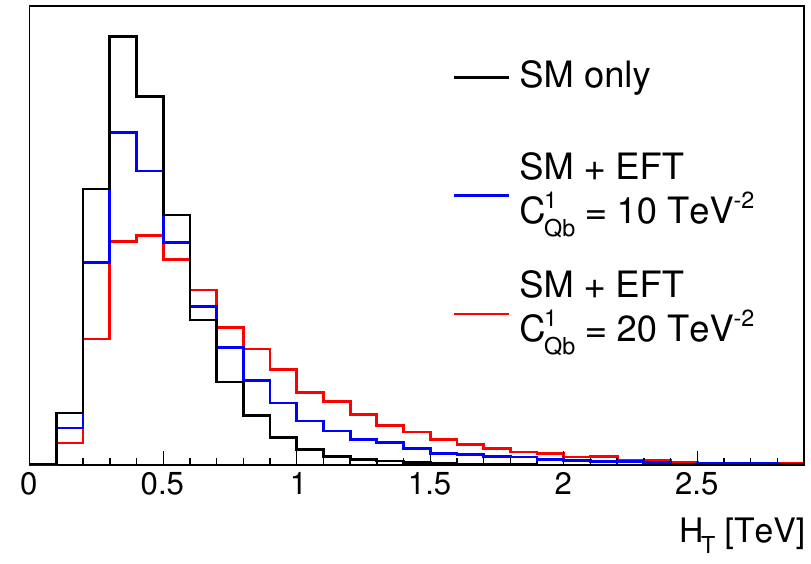
Figure 5 . Scalar sum of transverse momentum of all (cid:12)nal state physics objects in the event ( H T ). and 20 TeV (cid:0) 2 (red) respectively. This is a representative variable for the typical energy scale of the t (cid:22) tb (cid:22) b events and indeed we see that only a small fraction of the events are present above H T = 2